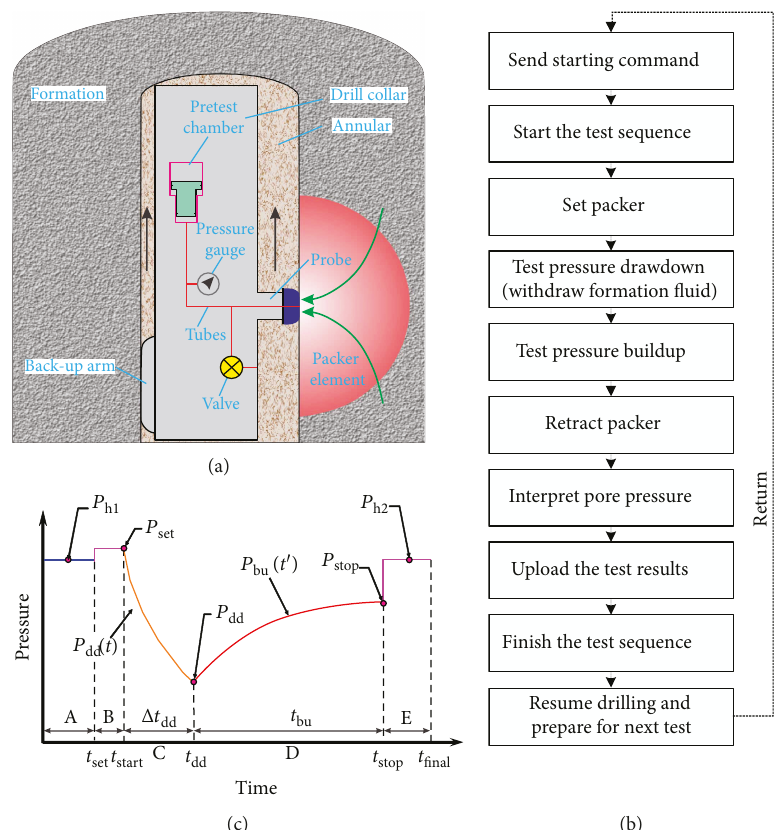
Figure 2: Testing principle of a typical probe-type FPTWD tester. (a) Major components of the typical FPTWD tester (reproduced from [4]). (b) Testing work fl ow (reproduced from [4]). (c) Testing pressure response curve (reproduced from [32 –